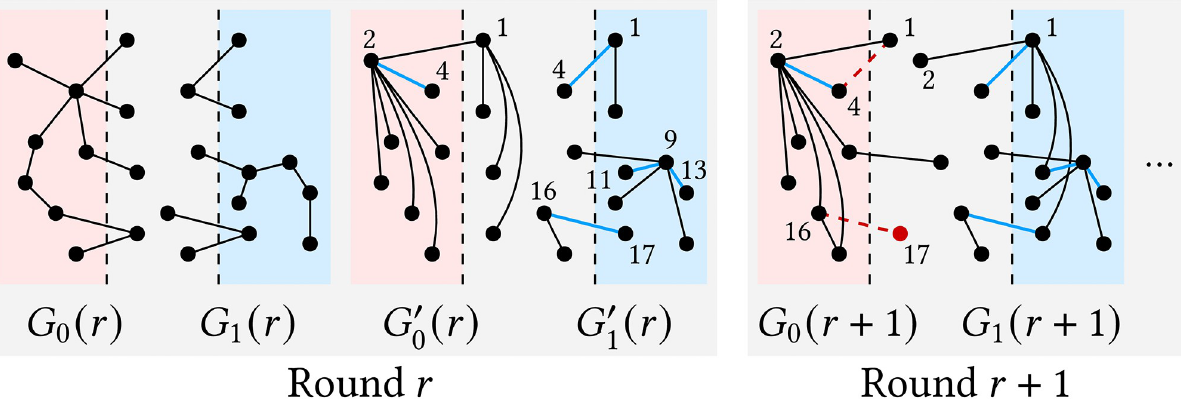
Fig 4. Intact edges in round r are marked in blue. The output of UniStar in round r becomes the input in round r + 1. Intact edge ( u , v ) in round r such that ξ ( u ) 6¼ ξ ( v )is excluded in a subgraph of round r + 1. The excluded intact edges are marked with red dashed lines.